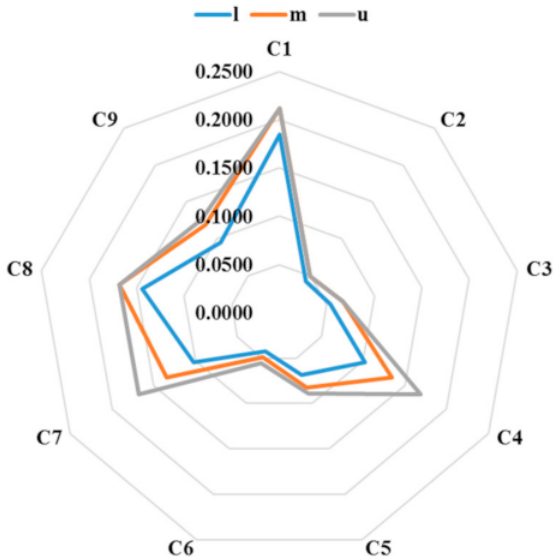
Figure 4. The optimal fuzzy weights of nine